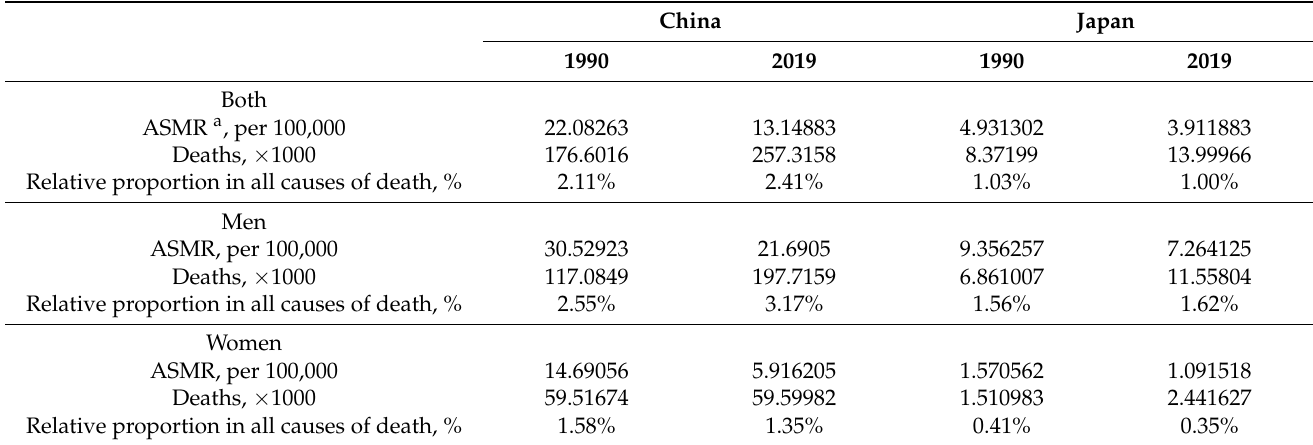
Figure 1. Trends in the ASMRs of esophageal cancer mortality by gender in China ( A ) and Japan ( B ) from 1990 to 2019, at all ages. ASMR: age-standardized mortality rate. Error bars represented the 95% CIs for esophageal cancer mortality. Table 1. Esophageal Cancer mortality in China and Japan between 1990 and 2019.